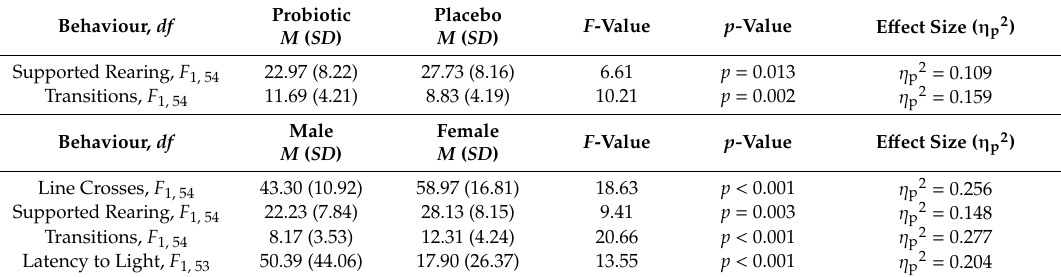
Table 3. Overview of treatment and sex main e ff ects in the light–dark box from factorial ANOVA analyses for line crosses, supported rearing, transitions, and latency to enter light, including means ( M ) and standard deviations ( SD